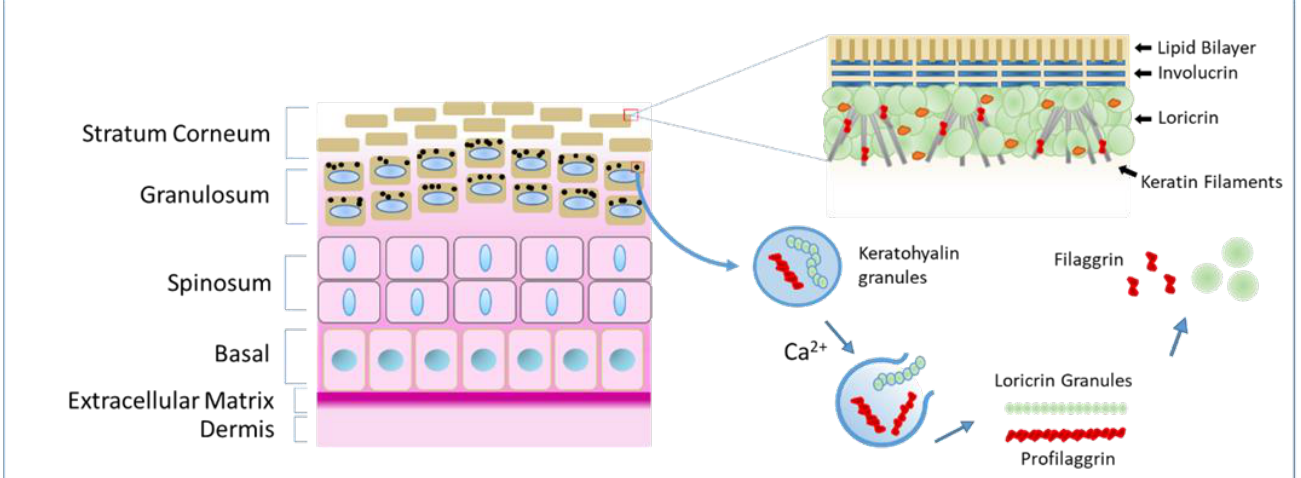
Figure 3. Normal development of the stratum corneum. Cornification follows the breakdown of keratohyalin granules to produce FLG (filaggrin) monomers and loricrin. Proteins including involucrin, loricrin and filaggrin, are crosslinked with transglutaminases, keratin filaments and lipids to form the protective barrier.